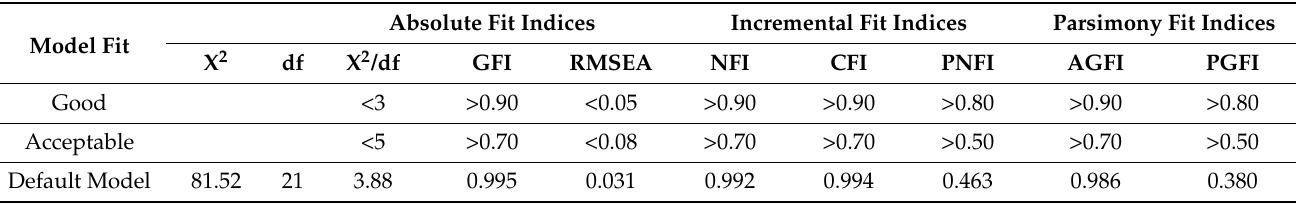
Table 5. Fit indices for Model